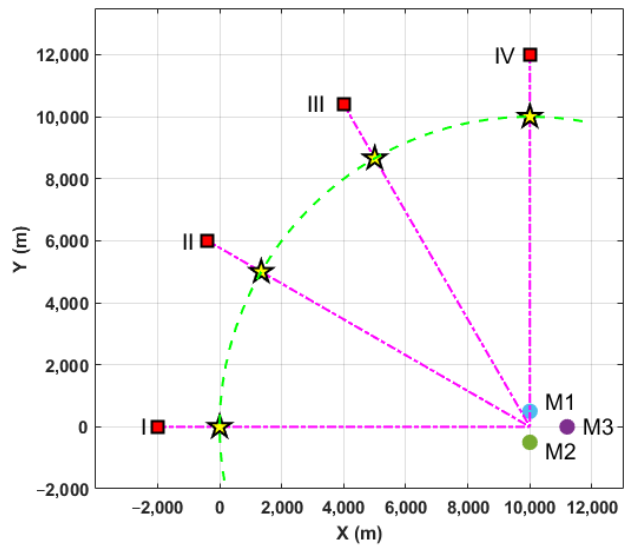
Figure 4. Initial position configurations of the